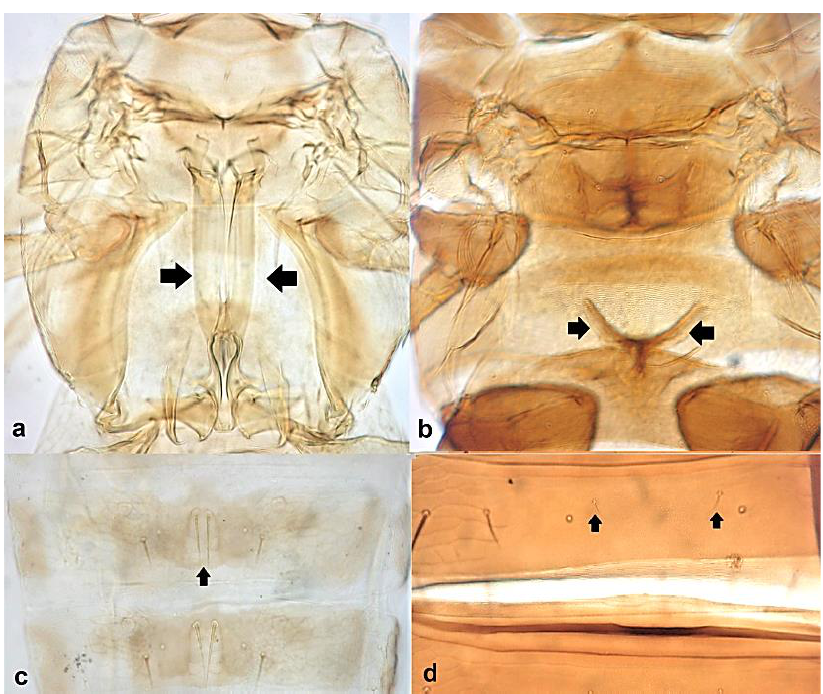
16 Metathoracic endofurca lyre-shaped, with arms extending well beyond length of segment (Figure 17a); median tergal setae on abdomen arising close to each other (Figure 17c) ............................................................................................... Dendrothripinae Metathoracic endofurca not lyre-shaped (Figure 17b), and usually not extending beyond length of segment; median tergal setae set far apart (Figure 17d) ................. 17